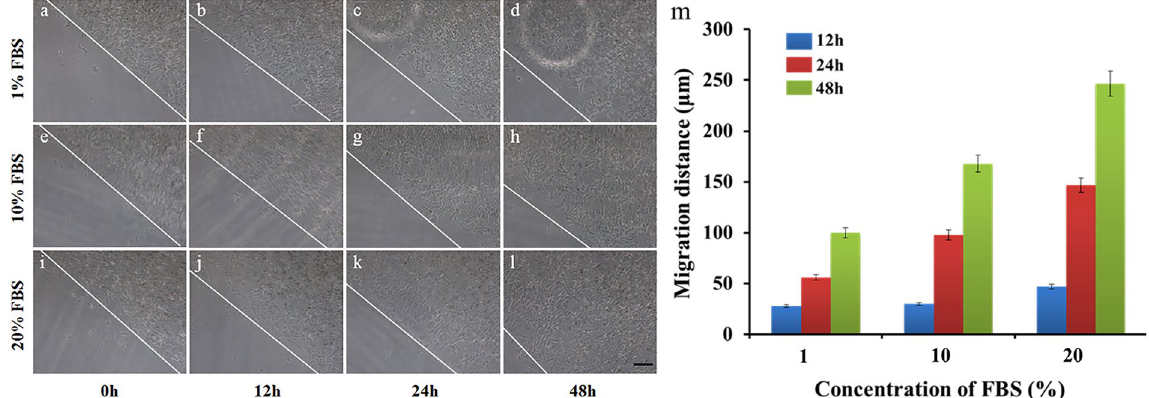
Figure 5. Representative images of MCF-7 cell migration under different FBS concentrations. ( a – d ) 1% FBS. ( e – h ) 10% FBS. ( i – l ) 20% FBS. The images were taken at 0, 12, 24, and 48 h. The lines indicate the initial leading edges at time 0 h and the migration edge after 12, 24, and 48 h. Error bars represent the SD from three different experiments on three devices (n = 3). P < 0.05. The scale bar in the picture represents 100 μ m.